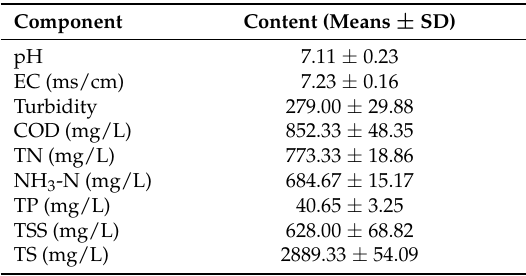
Table 1. Composition of the biogas slurry solid-liquid separation liquid.